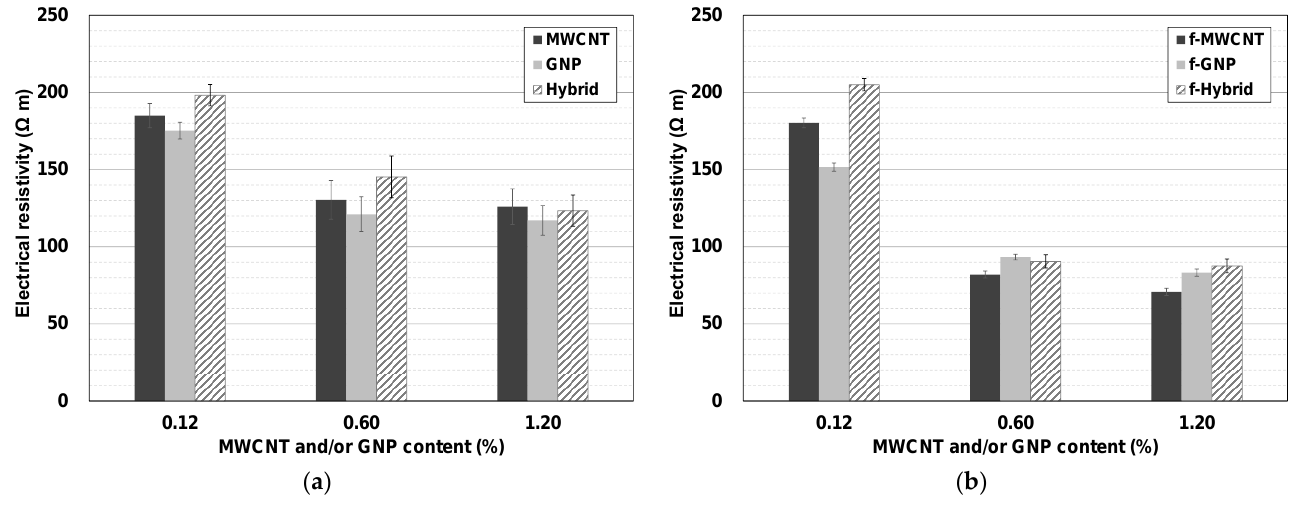
Figure 4. Effect of hybridization of MWCNTs and GNPs on electrical resistivity: ( a ) non-functionalization and ( b ) functionalization